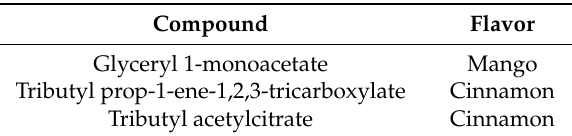
Table 8. Compounds observed only in the impinger.